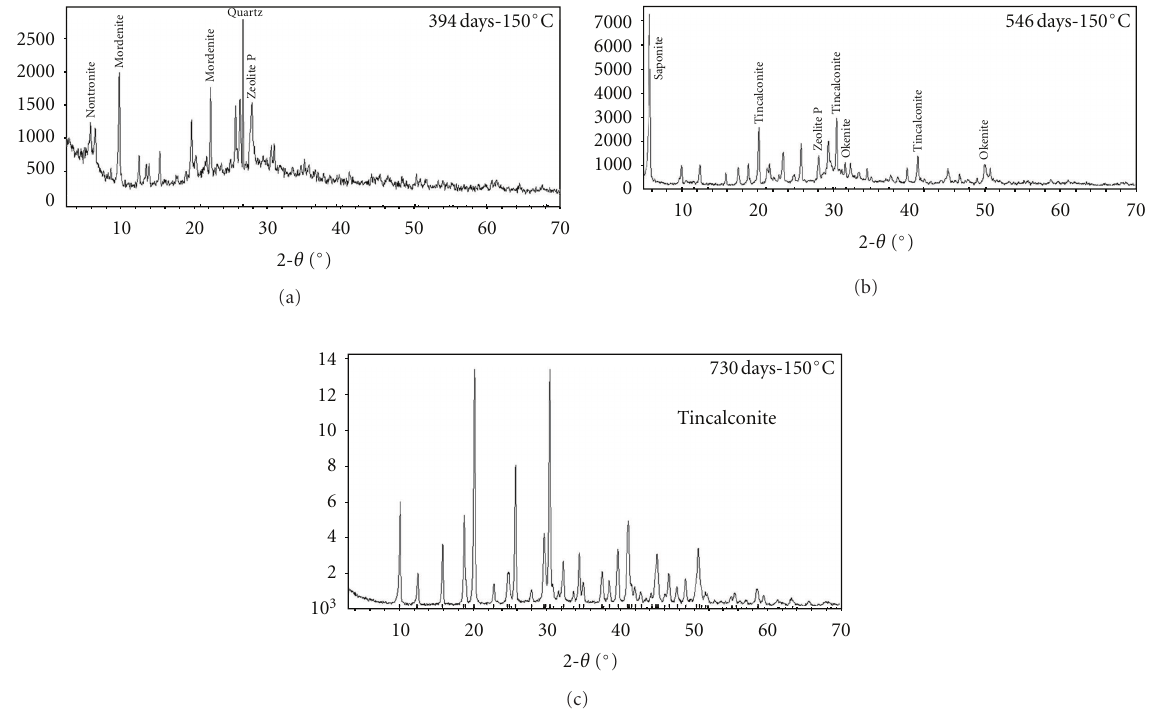
Figure 5: XRD of secondary product for di ff erent immersion